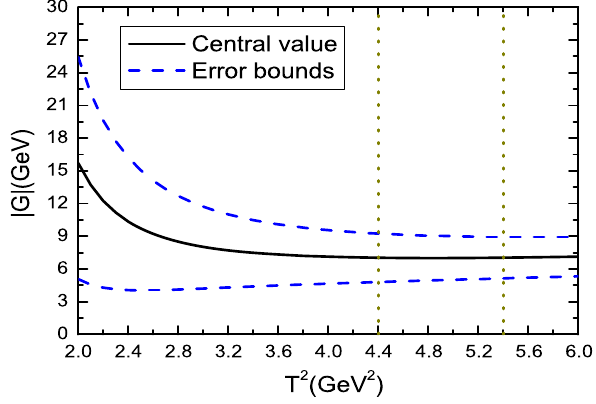
with variation of the 0